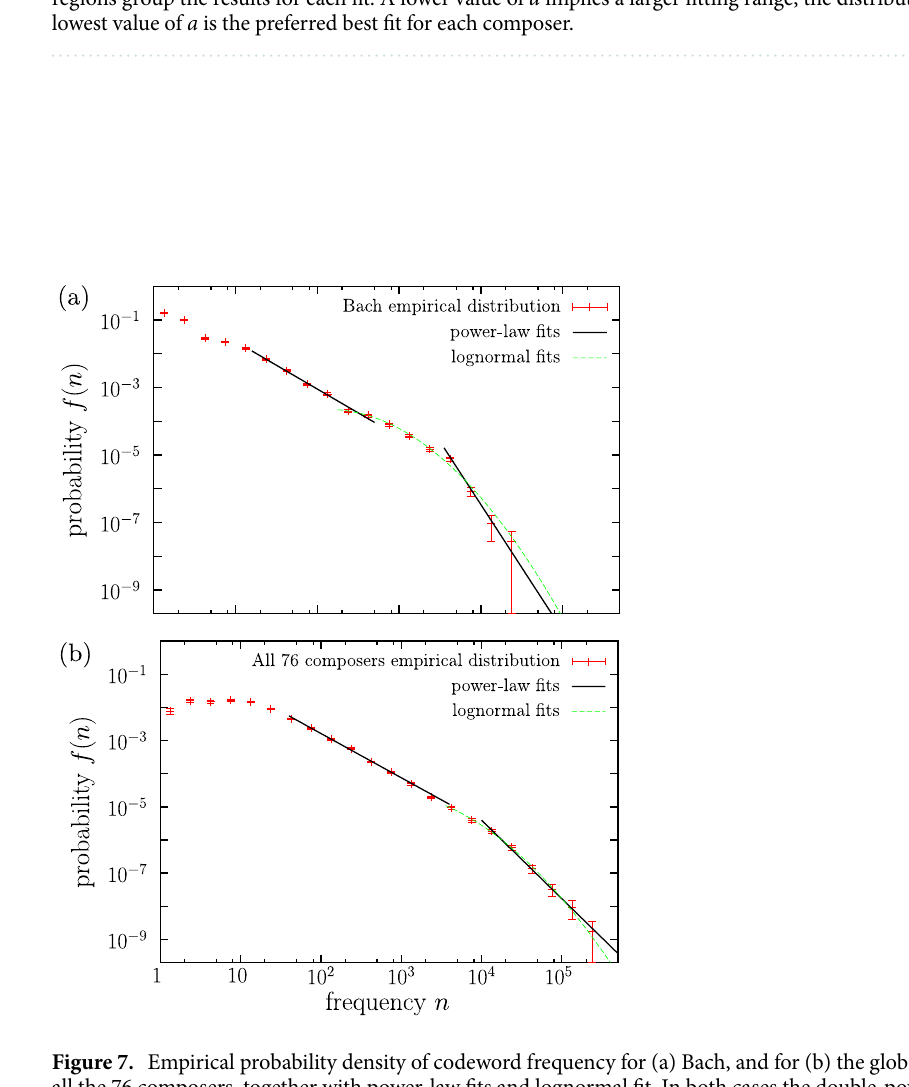
Figure 7. Empirical probability density of codeword frequency for (a) Bach, and for (b) the global dataset with all the 76 composers, together with power-law fits and lognormal fit. In both cases the double-power law fit is rejected, as the two fitted regimes do not overlap, and also the lognormal fit is unsatisfactory, as it excludes a significant part of the types (i.e., the value of a turns out to be too